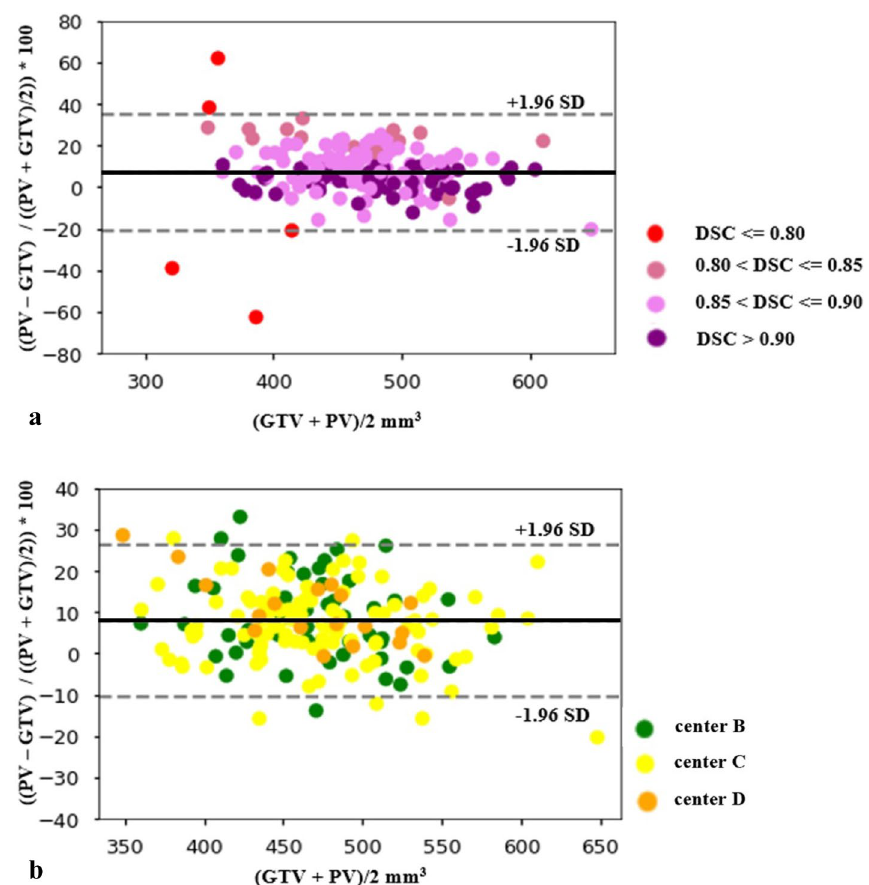
Figure 7. ( a ) Bland–Altman plot for inner ear volume of the entire test cohort showing percentage difference between predicted volume (PV) and ground truth volume (GTV) as a function of average of Ground Truth and Predicted Volume. The solid line shows the mean difference and the dotted line shows the limits of agreement. PV Predicted volume of inner ear, GTV ground truth volume of inner ear. The plot shows five clear outliers (red dots) with three cases which were under-segmented by 20%, 40% and 60% and two cases which were over- segmented by 40% and 60% respectively. The plot also shows the relationship between the DSC metrics and the level of under/over segmentation percentage. The outliers correspond to the DSC ≤ 0.80. ( b ) Bland–Altman plot for inner ear volume of the entire test cohort showing percentage difference between predicted volume (PV) and ground truth volume (GTV) as a function of average of ground truth and predicted volume after excluding the outliers shown in Fig. 5A (DSC ≤ 0.80). The solid line shows the mean difference and the dotted line shows the limits of agreement. PV Predicted volume of inner ear, GTV ground truth volume of inner ear. The plot shows that the model, on an average tends to over-segment by